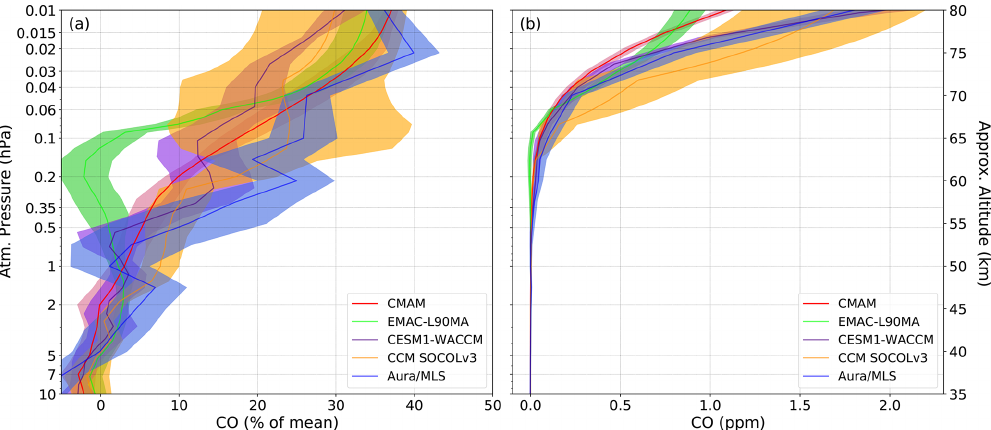
Figure 8. Vertical profiles of solar irradiance response in CO from CCMI-1 models and Aura/MLS observations for 2005–2017 at tropical latitudes (30 ◦ N–30 ◦ S). (a) The relative importance of the solar signal in CO presented as a percentage of the mean. (b) CO regression coefficient at the solar proxy ( β ) in mixing ratio (ppmv). Shadings indicate the standard